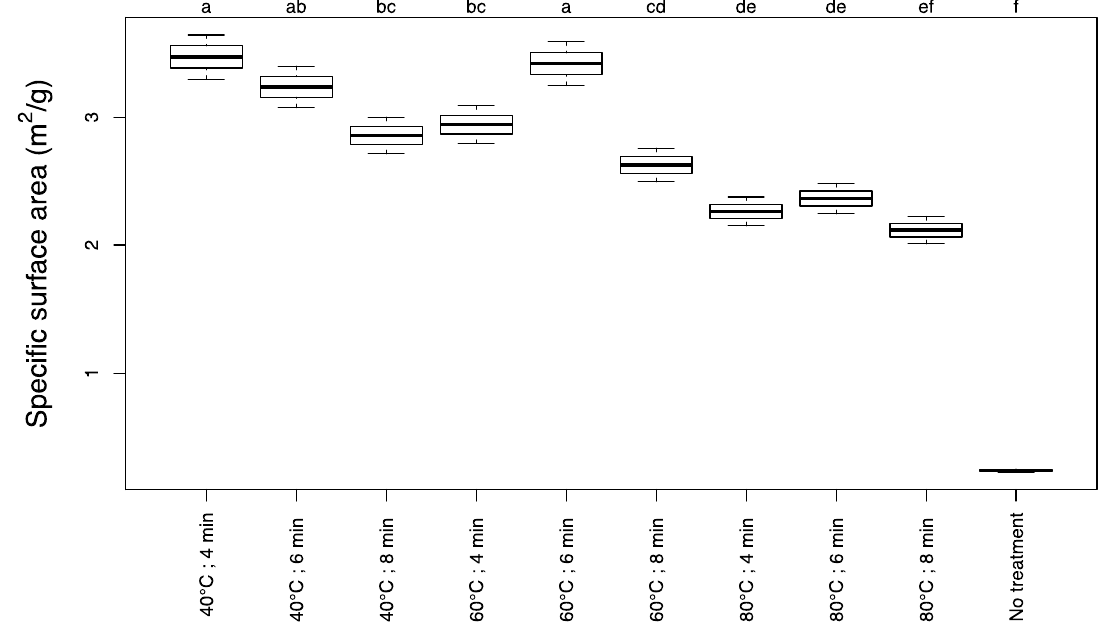
Figure 4. Specific surface of wood treated by HPU.